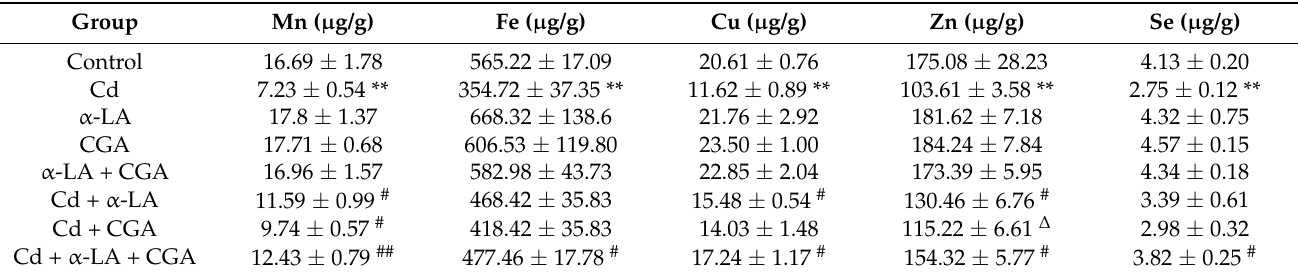
Note: Results represent mean ± SD of three samples per group. Concentrations of trace elements were detected by ICP-MS. ** p < 0.01 vs. control, # p < 0.05, ## p < 0.01 compared to the Cd-exposure group and ∆ p < 0.05 compared to the α -LA + CGA + Cd